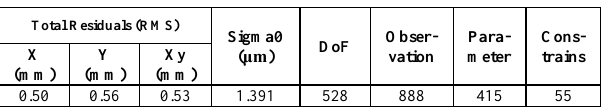
Table 3. Bundle adjustment report from session 1 processing